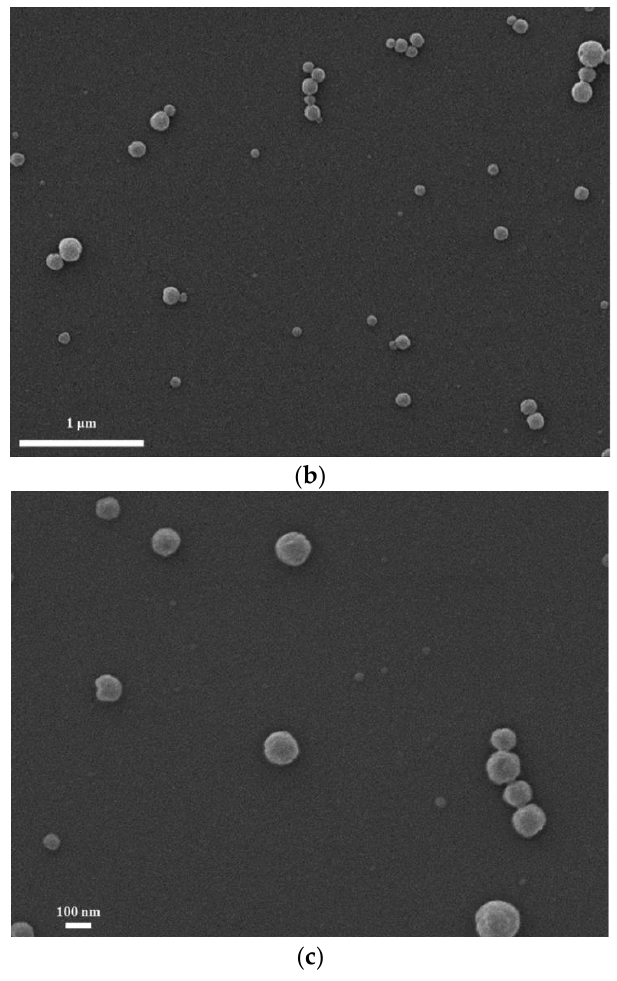
Figure 3. ( a ) Size distribution of CEL-NP(cellulolytic enzyme lignin nanoparticles); ( b ) SEM image of CEL-NP, magnification ×25,000; and ( c ) SEM image of CEL-NP, magnification ×50,000.